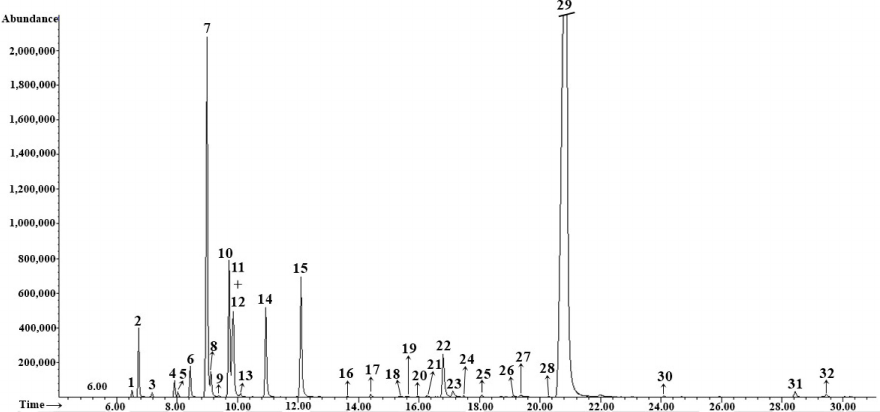
Figure 2. GC/MS chromatogram of essential oil isolated from wild fennel (1st stage: immature-pasty).